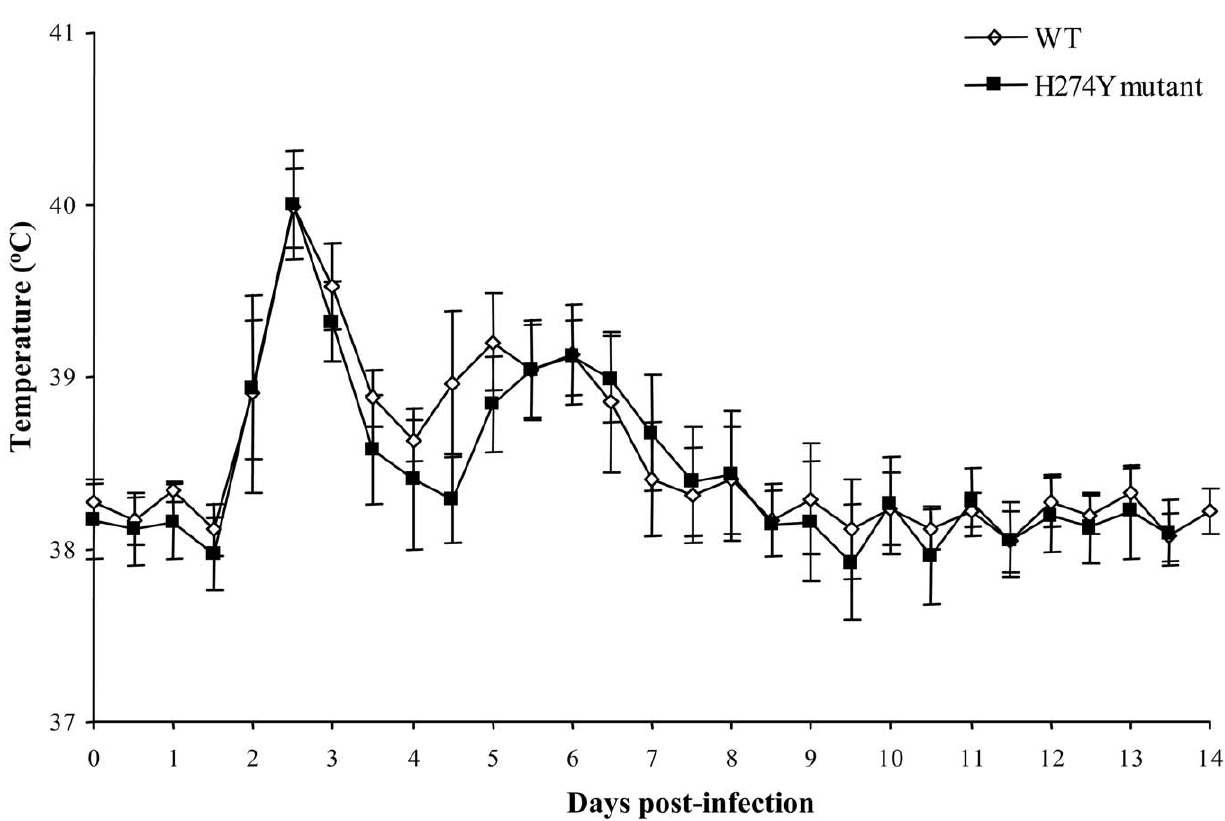
Figure 6. Body temperature of ferrets infected with wild-type (WT) or H274Y mutant isolates of pH1N1. Body temperatures were recorded by implanted thermometers during 14 days post-inoculation in groups of 4–5 ferrets infected with WT (A/Que´bec/147023/2009) or oseltamivir-resistant H274Y mutant (A/Que´bec/147365/2009) pH1N1 isolates.